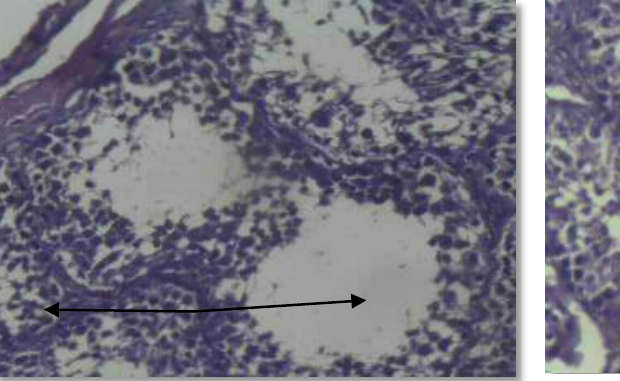
Figure (3): histopathological section of ram testis (July & August) showing degenerative changes and necrosis of tubules with immaturity and no sperms inside the lumen of tubule. HE stain